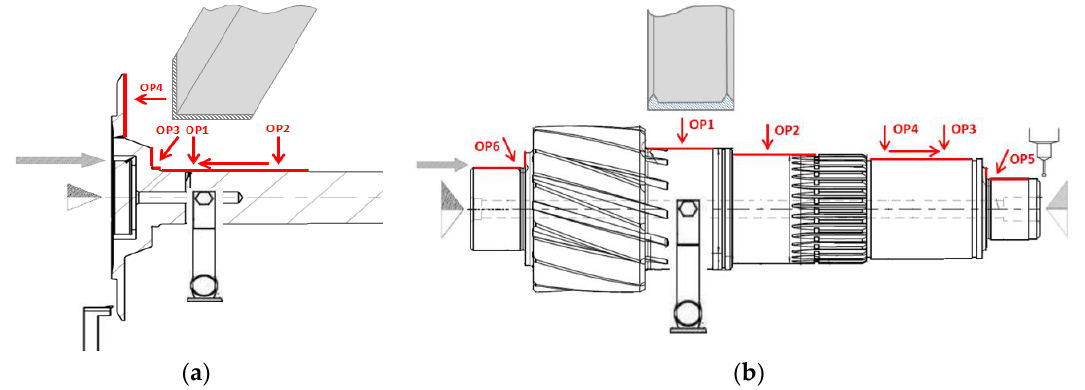
Figure 1. Face grinding with ( a ) an angular wheel and ( b ) a straight wheel.